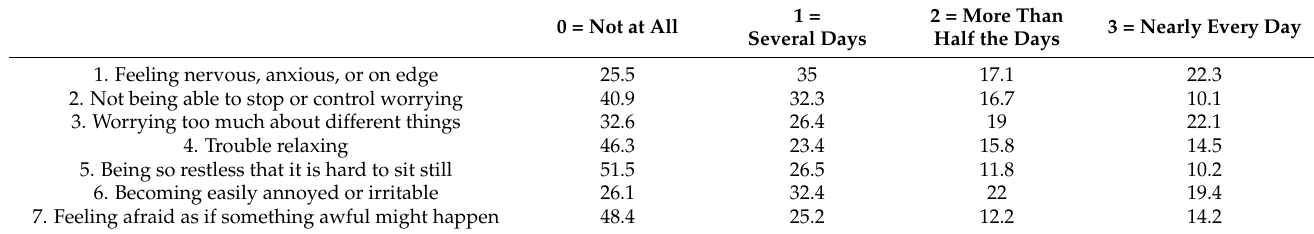
Table 3. The scores for Generalized Anxiety Disorder Scale-7 (GAD-7): Q13. In the past two